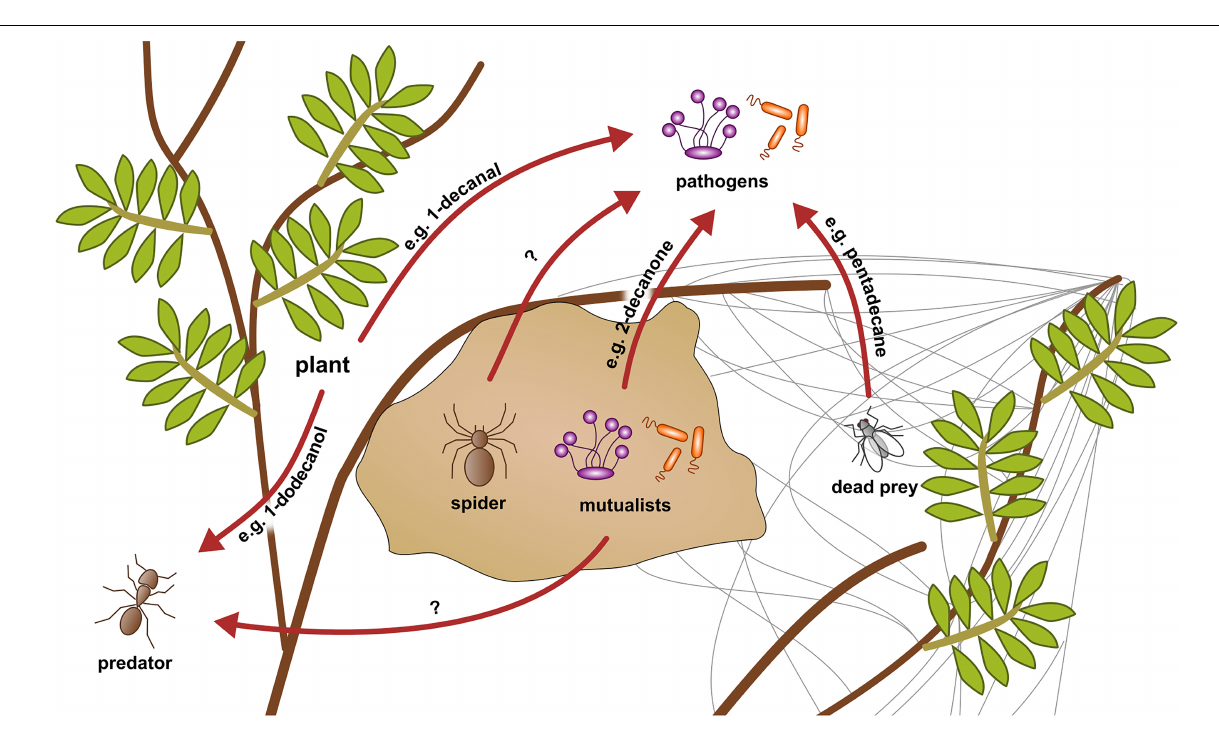
FIGURE 5 | Conceptual scheme of hypothetical VOC interactions in a social spider nest system. VOCs can be originated from the spiders themselves, their microbiome, dead prey, or the plants and inhibit pathogens and predators (red arrows). The example VOCs were found in the analyzed volatilomes of the present study. Their origin and influence are assumed based on